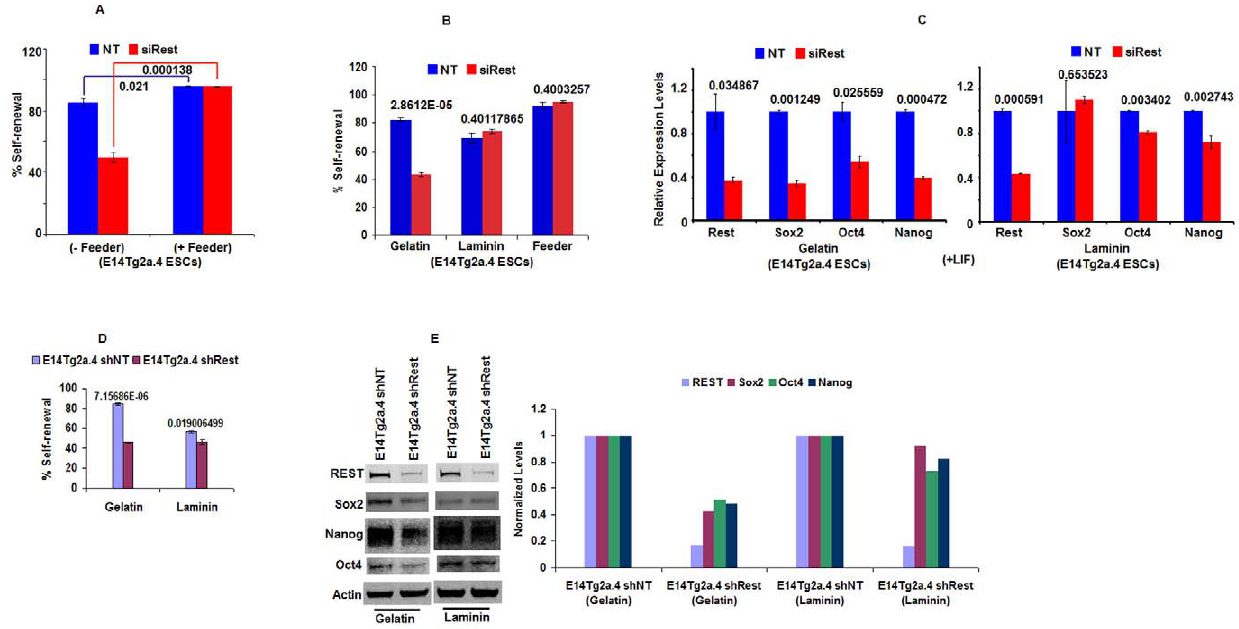
Figure 4. Extracellular cues provided by feeder cells compensate for REST-mediated loss of self-renewal and pluripotency in E14Tg2a.4 ESCs. (A,B) Rest Mediated pluripotency is influenced by extracellular environment in E14Tg2a.4 ESCs. (A) MEF feeder cells and (B) the extracellular matrix component, laminin, countered lowered self-renewal in E14Tg2a.4 ESCs treated with siRNA mediated knockdown of REST (siRest). Percentages of self-renewing colonies in ES, NT and siRest treated cells after alkaline phosphatase assay are shown for each conditions (as labeled on x-axis). Both MEF and laminin condition resulted in maintenance of self-renewal compared to gelatin condition after siRest treatment. Number above bars are p-values (n=3). Error bars are standard error of means. (C) Laminin maintains the expression of pluripotent markers in siRest treated E14Tg2a.4 ESCs. ESCs transfected with siRest or NT were plated on gelatin- or laminin-coated surfaces and were analyzed by QRT-PCR assays to determine the expression levels of Sox2, Nanog, and Oct4 transcripts. Number above bars are p-values (n=3). Error bars are standard error of means. (D,E) Laminin counters lowered self-renewal and pluripotency due to loss of REST in shRest-mediated stable knock-down of REST in ESCs. (D) shRest lowered self-renewal when cells were cultured on gelatin but not on laminin. Percentages of self-renewing colonies in shRest and NT cells are shown for each conditions (as labeled on x-axis). Number above bars are p-values (n=3). Error bars are standard error of means. (E) Stable shRest lines, when compared to shNT lines, of ESCs showed decreased levels of REST proteins when the cells were cultured either on gelatin or on laminin; however, the levels of Sox2, Nanog, and Oct4 were decreased only when cells were cultured on gelatin but not laminin.